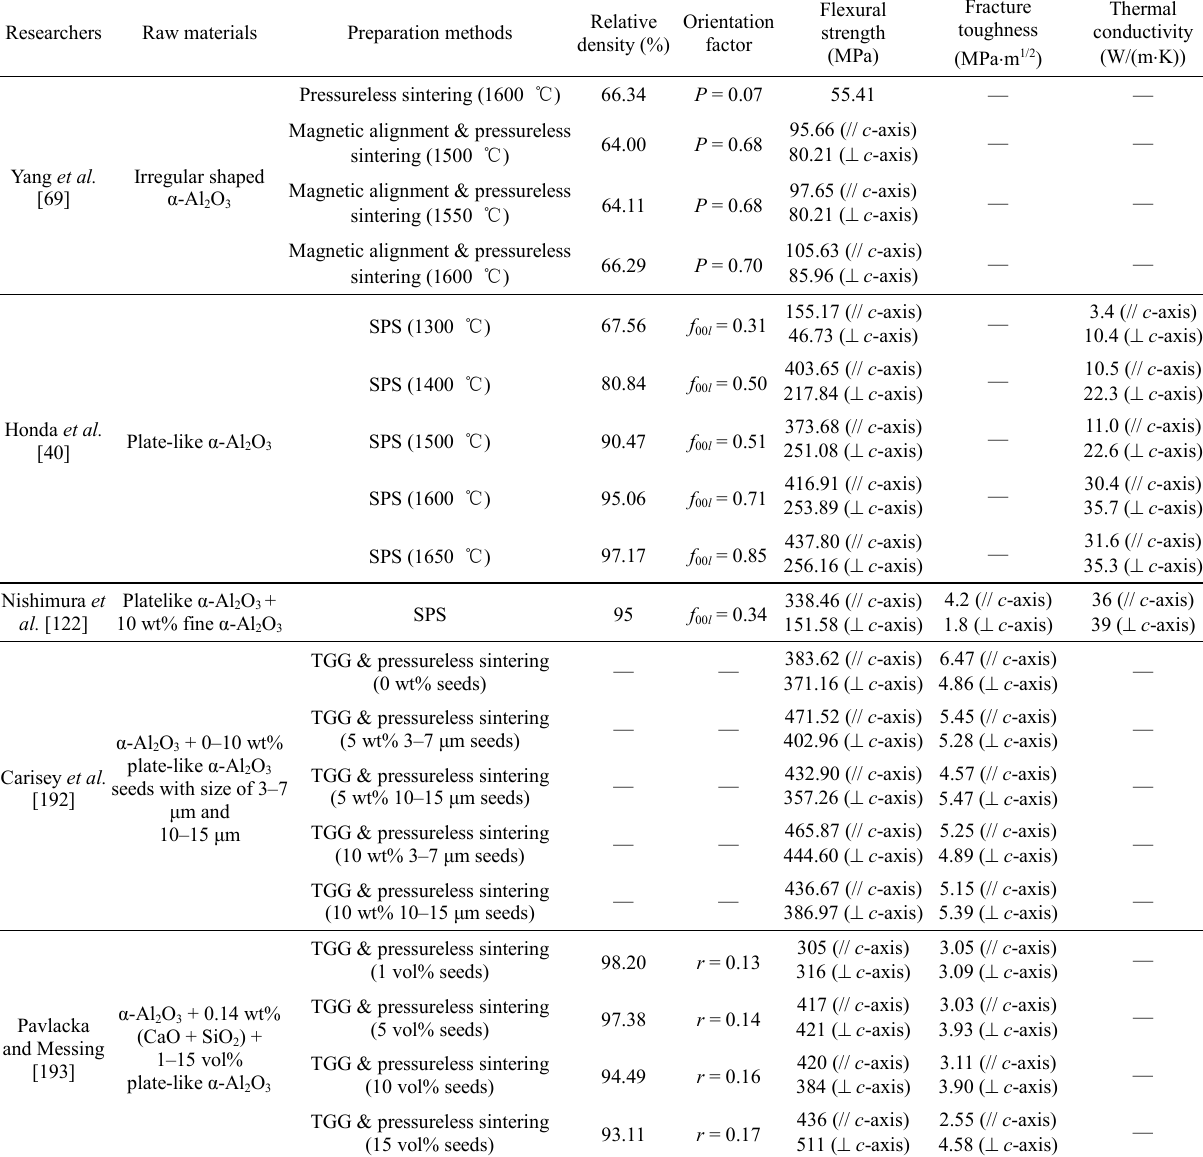
Table 5 Properties of textured Al 2 O 3 matrix